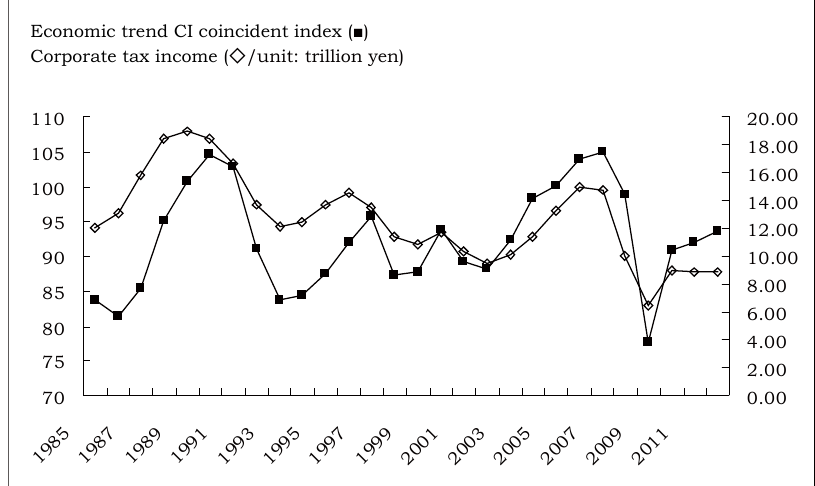
Figure 1. Fluctuations of economic trend CI coincident index